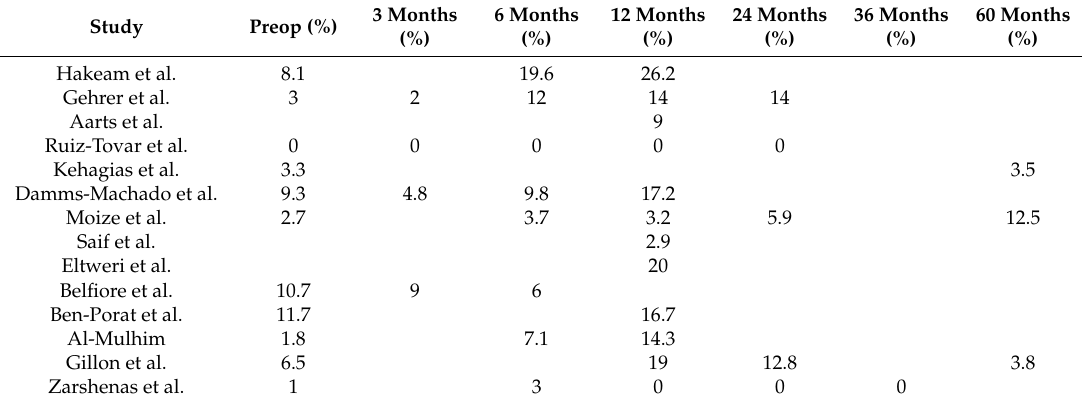
3 Months 6 Months 12 Months 24 Months 36 Months 60 Months (%) (%) (%) (%) (%) (%)